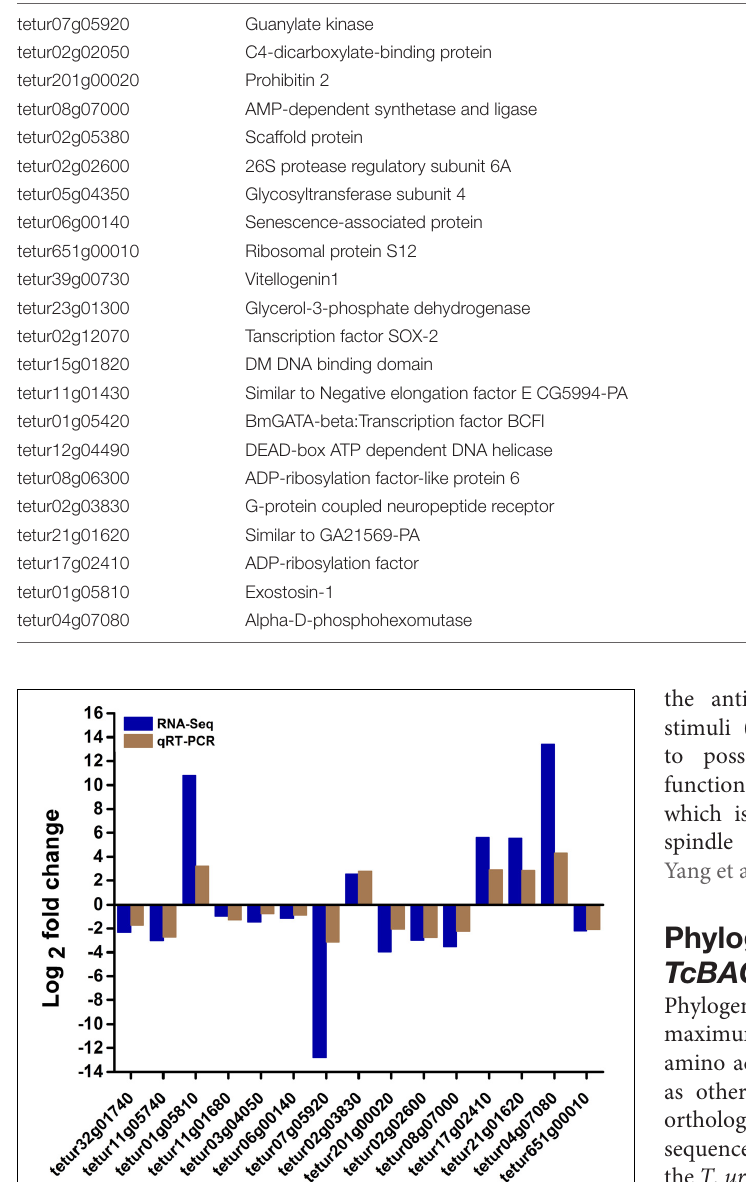
and light receptors involved in signal transmission